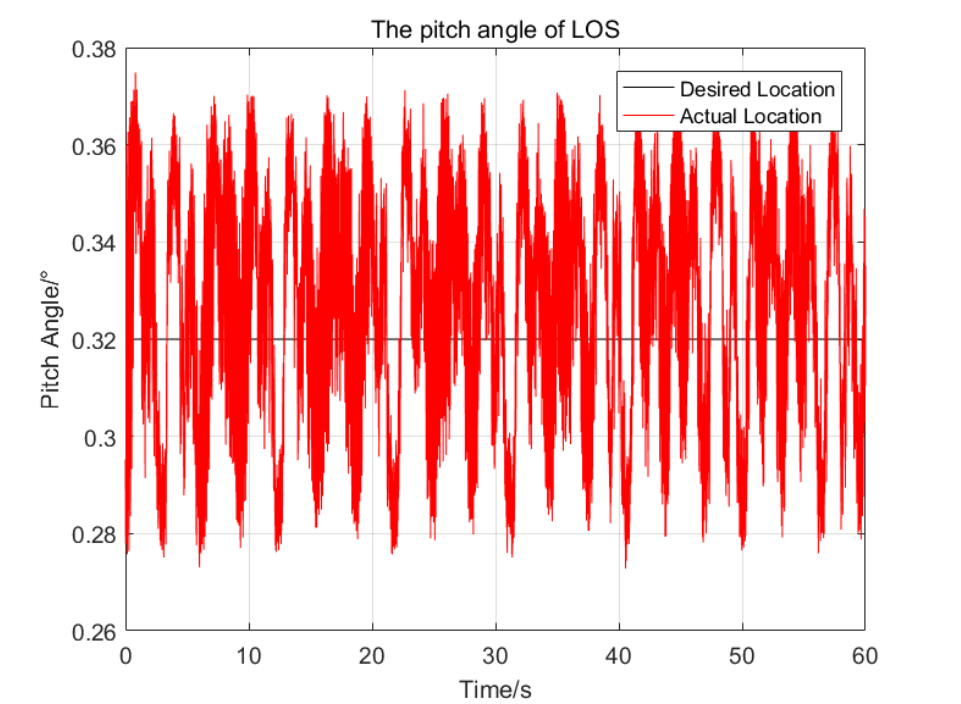
Figure 10. The experimental result of the pitch angle generated by the proposed